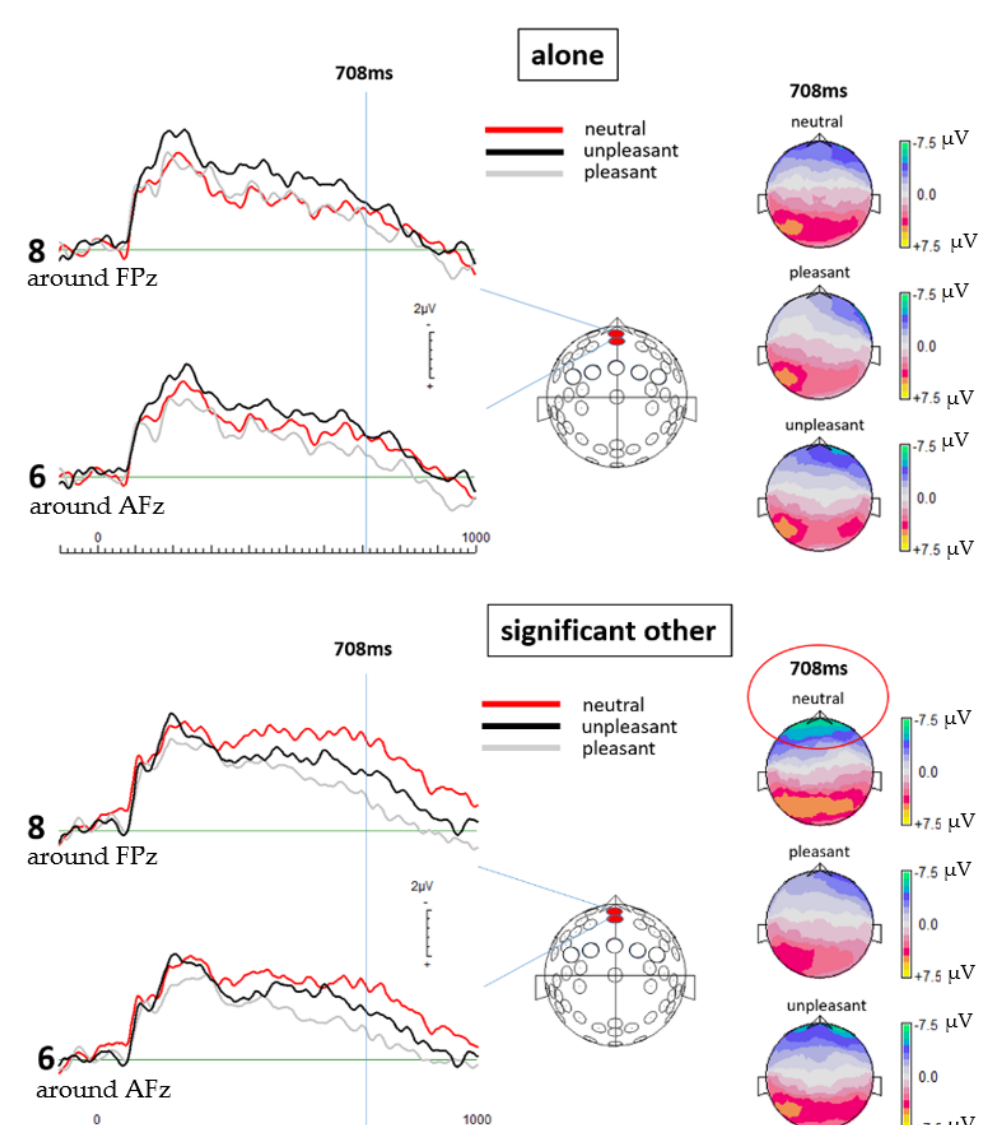
Figure 1. On the left: ERPs from both selected electrode locations for all three emotion categories and both experimental conditions are shown. On the right: Topographical maps for each valence category and both experimental conditions are shown. The ERPs and their topographic display show clearly that neutral pictures in the significant other condition elicit the highest levels of brain activation at mid-frontal electrode locations, also emphasized by the top topographical map in the significant other condition (circled in red color). The topographical maps further show cortical activity elicited in the significant other condition to be constantly more negative than in the alone condition, regardless of the valence category. This further emphasizes to what extend social presence alters human brain activity and consequently, most likely also resulting decision-making mechanisms.